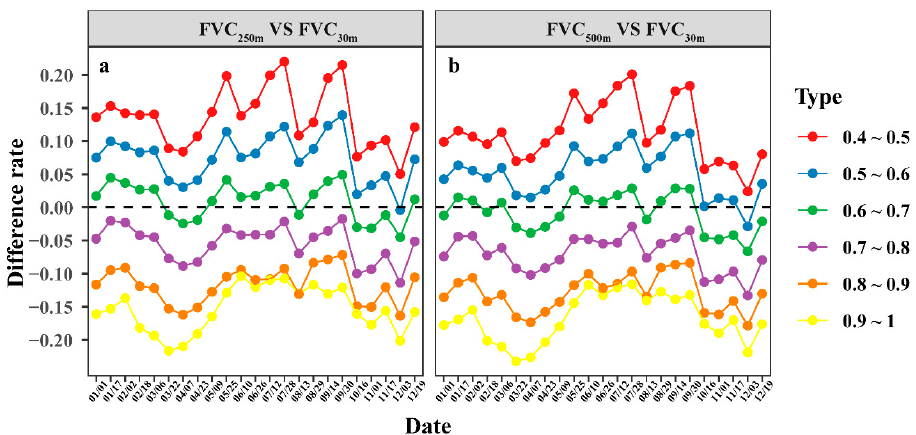
Figure 8. The difference rate of FVC for each 0.1 unit step with respect to FVC 30m over time for 250 m and 500 m resolution images. ( a ) Difference rate between FVC 250m and FVC 30m . ( b ) Difference rate between FVC 500m and FVC 30m .